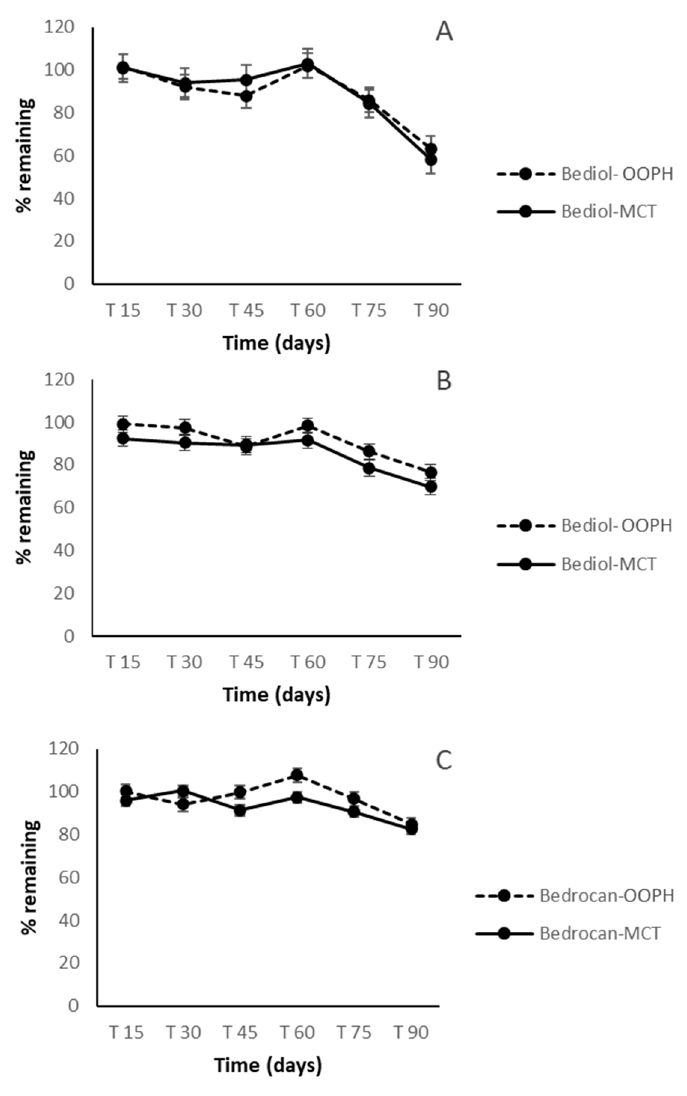
Figure 2. ∆ 9 -THC trends in Bediol ® ( A ), Bedrocan ® ( C ), and CBD in Bediol ® ( B )-based oils as a function of the storage time and lipid sources: PhEur-grade olive oil (OOPH) and medium-chain triglycerides (MCTs).